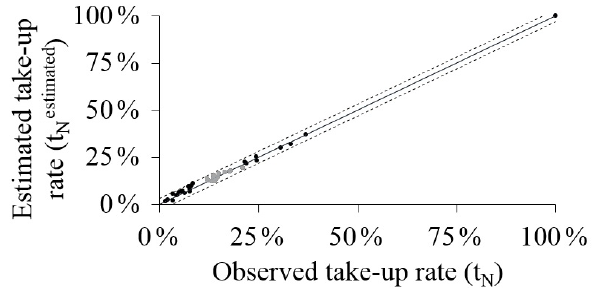
Figure 8. Comparison between the take-up rates observed and es- timated using the model developed in this study. Grey points cor- respond to the period 1997–2016, which was used to calibrate the model. Dashed lines represent a buffer of ± 0 . 03.